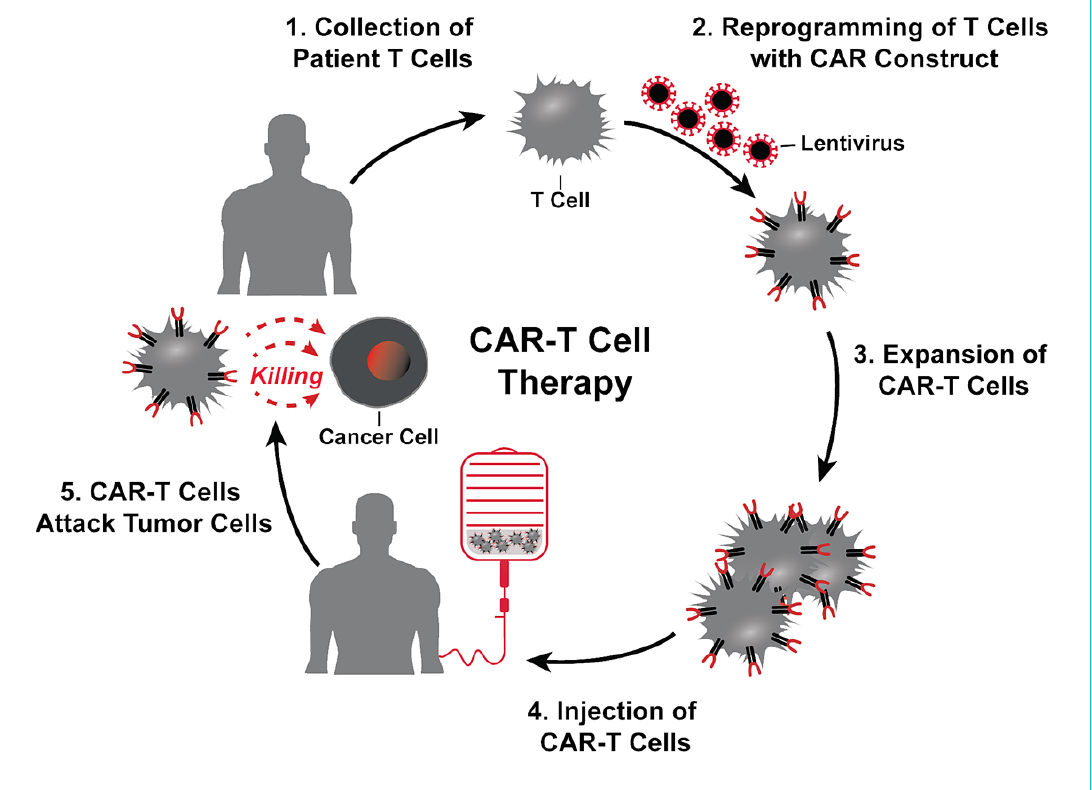
Figure 1: The treatment cycle for CAR-T cell therapy: patients’ T cells are isolated via leucapheresis (1). Once secluded, autologous T cells are genetically modified with the CAR construct (3). That means that the cells are reprogrammed to facilitate targeted killing of CD19+ B cells. The treatment process is completed with intravenous infusion of CAR-T cells back to the patient (6) (cf.